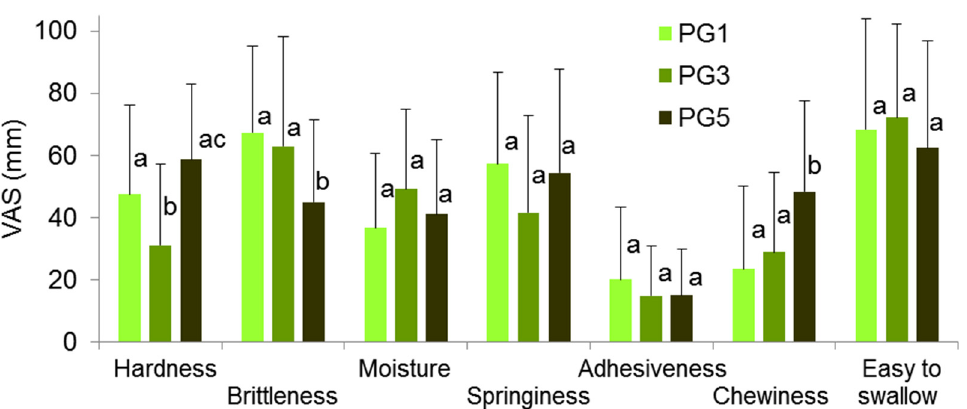
Figure 5. Sensory attributes of PGs. Means with standard deviations are given. Differences are significant ( p < 0.05) between means labeled with different lowercase letters (a, b, and c) ( n = 16).